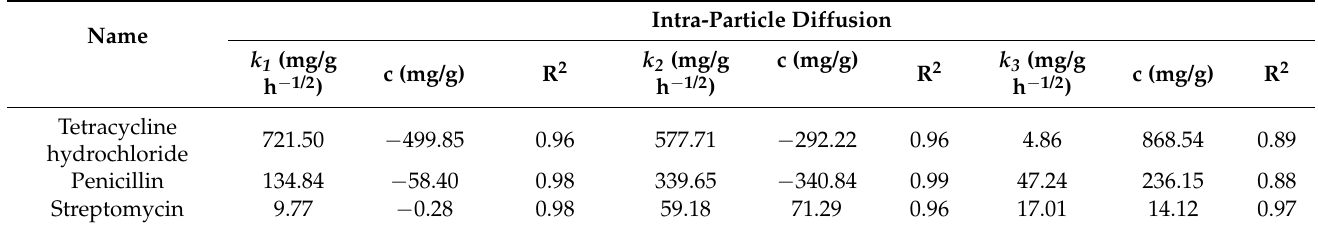
Table 3. The intra-particle diffusion model parameters of three antibiotics on MCNs.